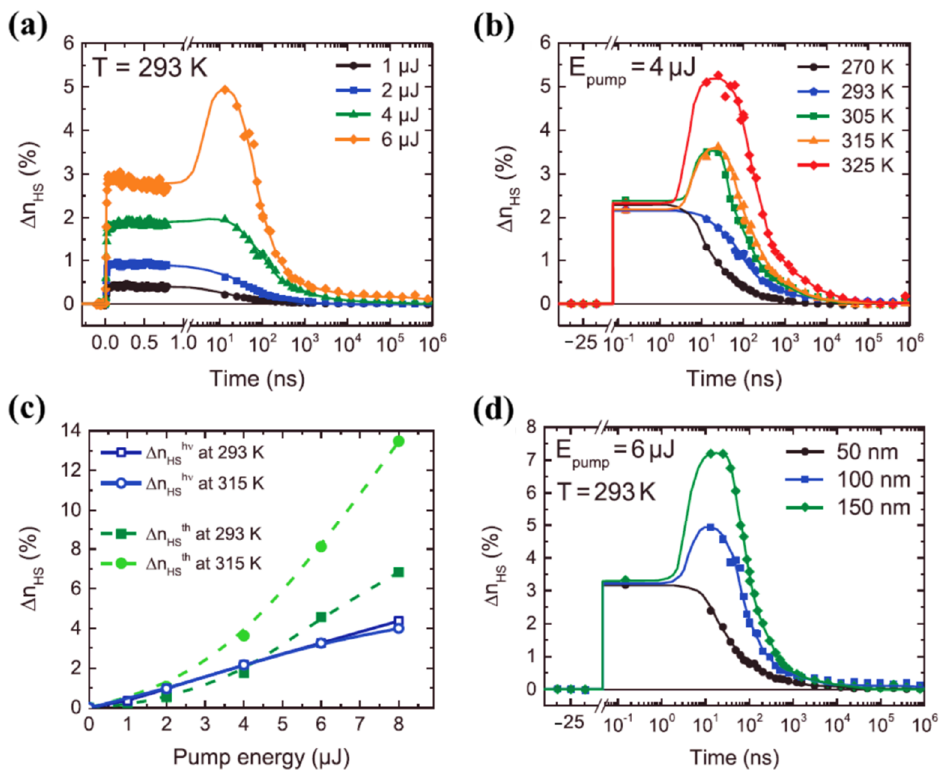
Figure 11. ( a ) The high spin state molecular fraction of a 100 nm [Fe(HB(tz) 3 ) 2 ] thin film with respect to the time delay, for different excitation energies. ( b ) At constant excitation energy, the time evolution of the high spin fraction of 100 nm thick thin film for different temperatures. ( c ) The comparison of high spin fraction formed due to photo-switching and thermal step at two different temperatures with respect to the pump energy. ( d ) The photo-response of a thin film of [Fe(HB(tz) 3 ) 2 ] to a excitation energy of 6 µJ, although of a different film thickness. Reprinted with permission from Ref. [87]. Copyright 2019 John Wiley and Sons.